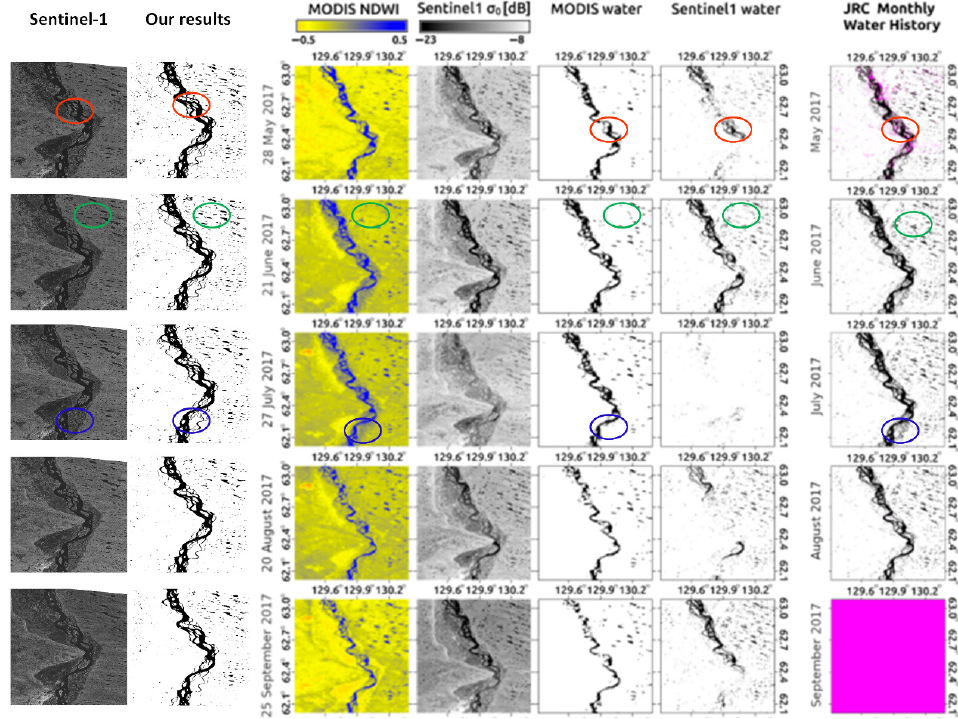
Figure 17. Comparison with the work of Mizuochi et al.